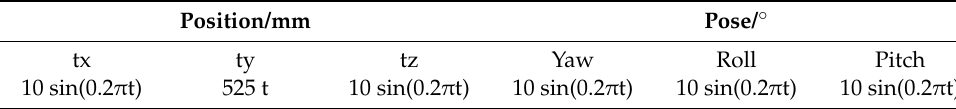
Table 1. Simulation parameter setting of the target motion.